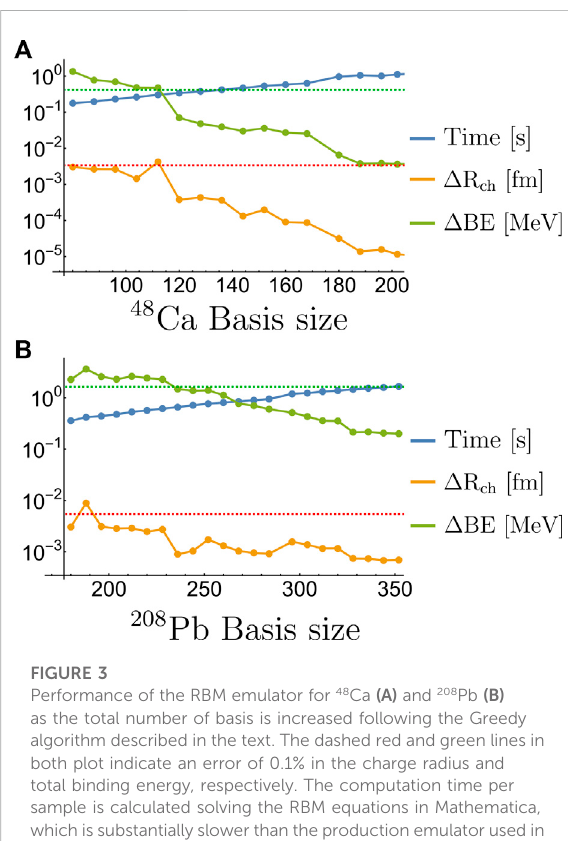
FIGURE 3 Performance of the RBM emulator for 48 Ca (A) and 208 Pb (B) as the total number of basis is increased following the Greedy algorithm described in the text. The dashed red and green lines in both plot indicate an error of 0.1% in the charge radius and total binding energy, respectively. The computation time per sample is calculated solving the RBM equations in Mathematica, which is substantially slower than the production emulator used in the calibration and detailed in Sec.